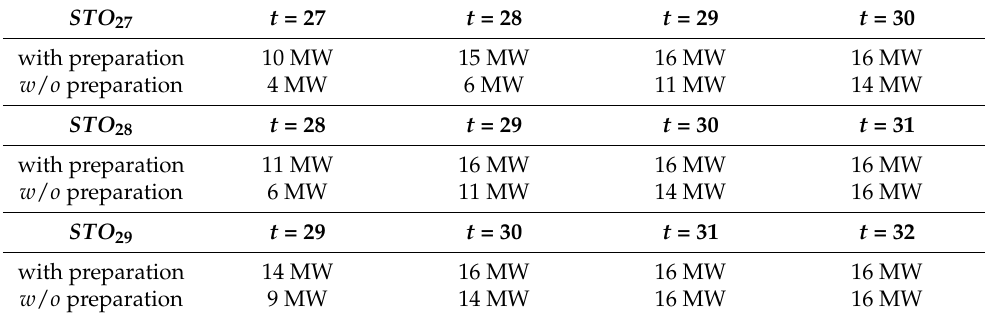
Table 4. Total available power of CGs at each STO l